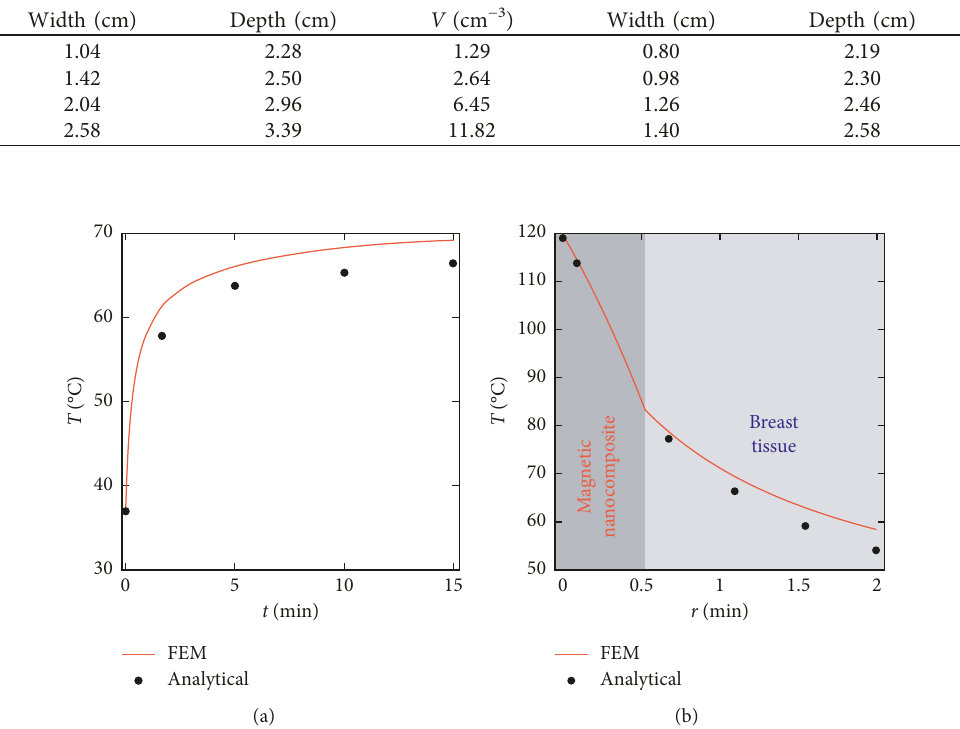
Figure 4: Comparison of temperature as function of (a) time at a point distance from the center of composite after 15mins of heating between FEM model and the analytical model by Andr¨a et al.